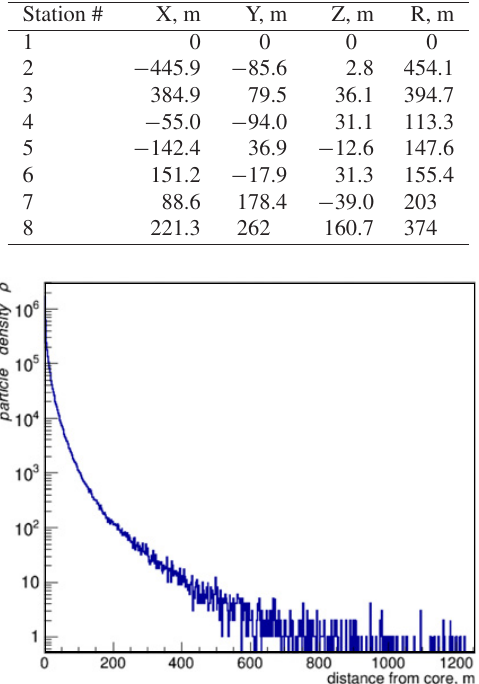
Figure 1. Aerial view of the Horizon-T detector system. Table 1. HT detection points coordinates.